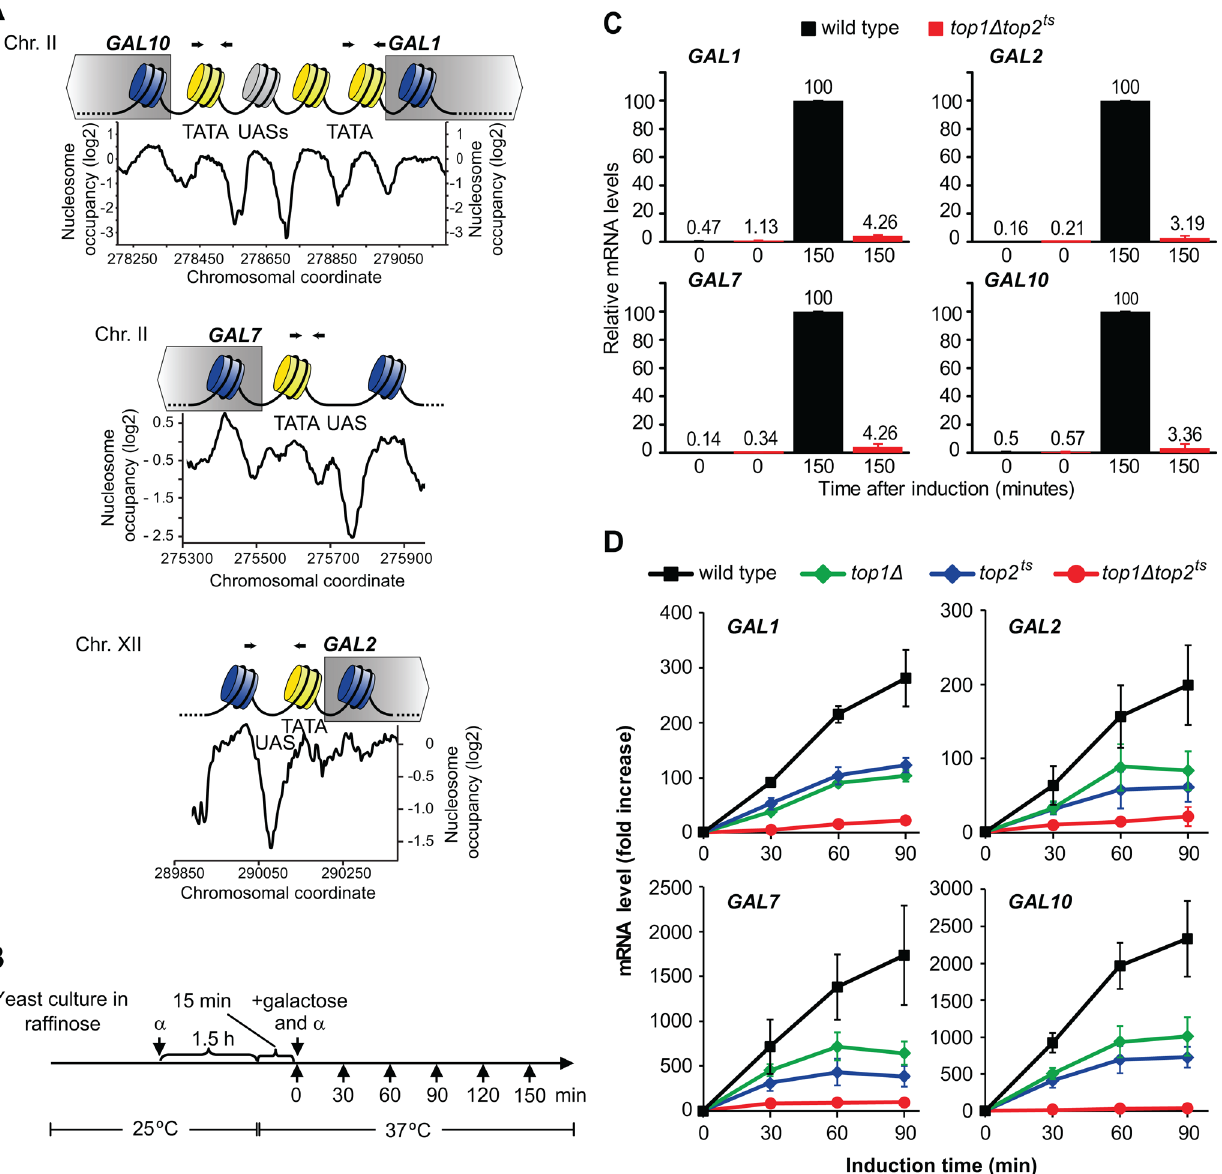
Fig 1. GAL gene transcription requires topoisomerase activity. (A) Organization of the GAL genes. GAL1 and GAL10 are located on Chromosome II (Chr. II) and share a promoter with two UASs and three nucleosomes. The GAL7 promoter, located immediately after the GAL10 open reading frame on Chr. II, contains a single UAS and a single nucleosome. The GAL2 promoter is similar to the GAL7 promoter, but is located on Chr. XII. Promoter nucleosomes are illustrated in yellow. A promoter nucleosome occupancy profile [6] is shown below each gene (black line) indicating chromosomal coordinates of nucleosomes. Primers used in ChIP experiments are indicated by black arrows. UAS, Upstream Activating Sequence. TATA, TATA box. (B) Experimental setup. Cells were grown at 25°C in raffinose media (de-repressive conditions), and α -factor was added to arrest cells in G1. After 1.5 hours, cells were shifted to the restrictive temperature. After Top2 inactivation for 15 minutes, cells were treated with galactose to induce the GAL genes, α -factor was added again to keep cells in G1, and samples were collected at the indicated time points. α , α -factor. (C) Induction of GAL1 , GAL2 , GAL7 , and GAL10 in wild type and top1 Δ top2 ts cells. Cells were treated as illustrated in (B), and samples were collected 0 and 150 minutes after galactose treatment. mRNA was isolated, and the levels of the individual GAL genes and two control genes ( GAPDH and ACT1 ) were quantified by qPCR. mRNA levels of the GAL genes were calculated relative to the mean of the mRNA levels for GAPDH and ACT1 for each time point and the value obtained in wild type at the latest time point was set to 100. Numbers indicate relative mRNA levels. Averages from two individual experiments are shown with error bars representing ± one standard deviation. (D) Induction of GAL1 , GAL2 , GAL7 , and GAL10 in wild type, top1 Δ , top2 ts , and top1 Δ top2 ts cells. Cells were treated as shown in (B), and samples were collected at the indicated time points for qPCR measurements of GAL gene mRNA levels. mRNA levels are presented as fold increase relative to the level at time point 0. Averages from three individual experiments are shown with error bars representing ± one standard